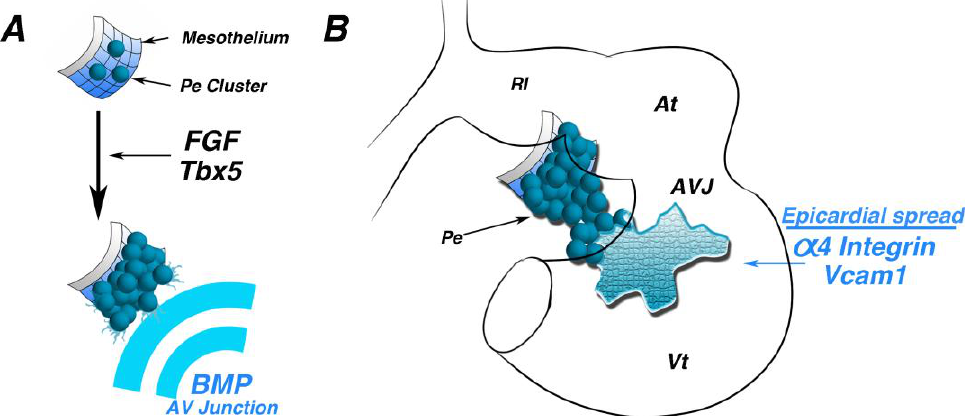
Figure 3. Morphogenetic induction of the PE. ( A ) Schematic of early